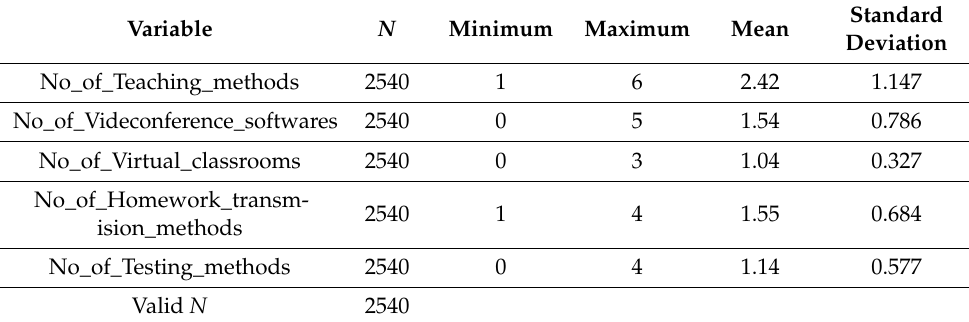
Table 19. Descriptive Statistics for main parameters of the online system.